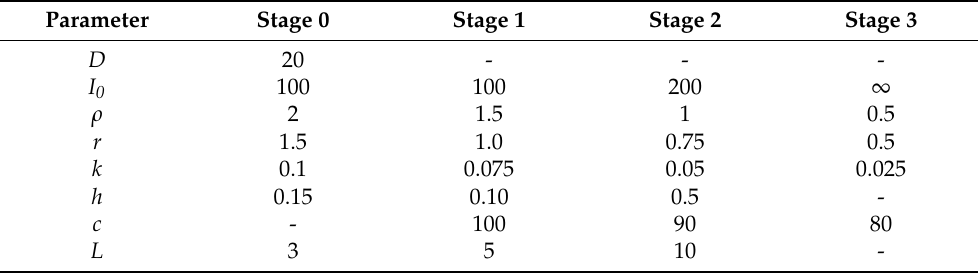
Table 1. Parameter values for the first numerical experiment. The first column contains model parameters. Stages from 0 to 3 correspond to different supply chain participants, from retail (stage 0) to a source of raw materials (stage